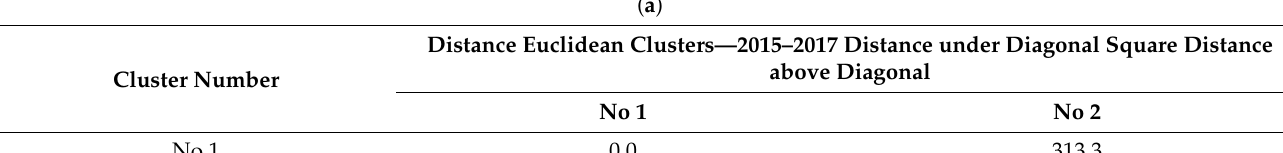
Distance Euclidean Clusters—2015–2017 Distance under Diagonal Square Distance